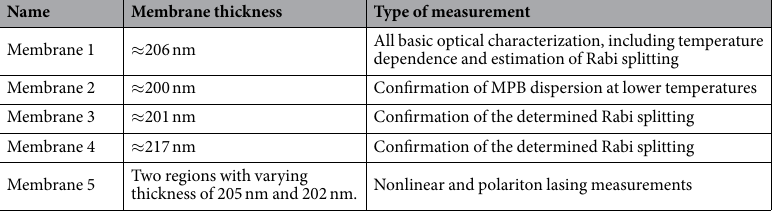
Table 1. Description of the membranes used in this